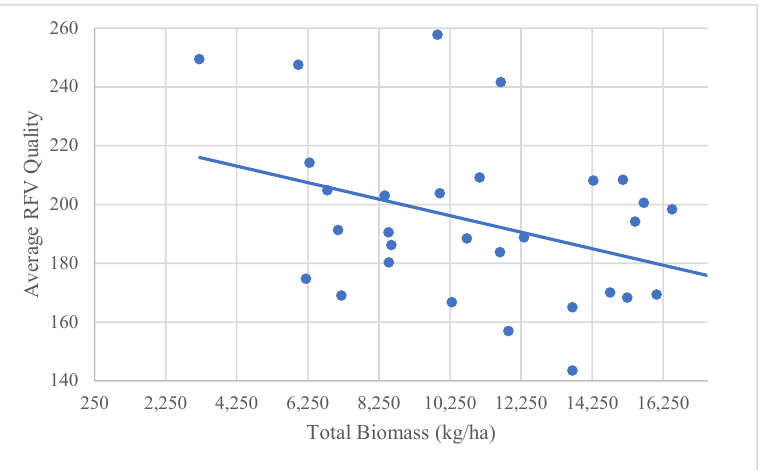
Figure 5. The WUE of alfalfa under deficit irrigation using subsurface drip irrigation. The blue dots show individual WUE per alfalfa harvest. Table 6. Water use efficiency (WUE) of alfalfa from 2018–2022.